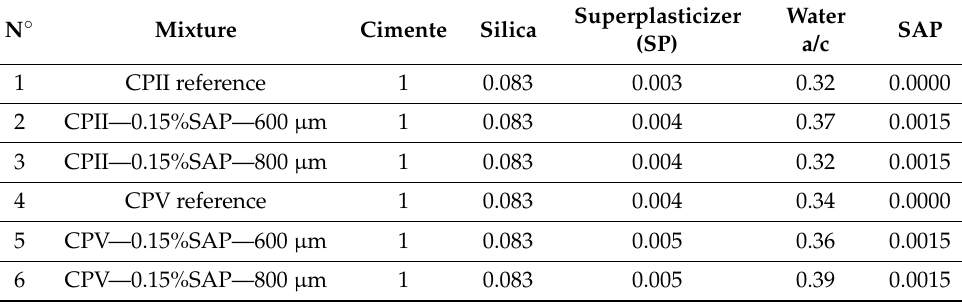
Table 4. Unit mass traces of PAA: reference and with added